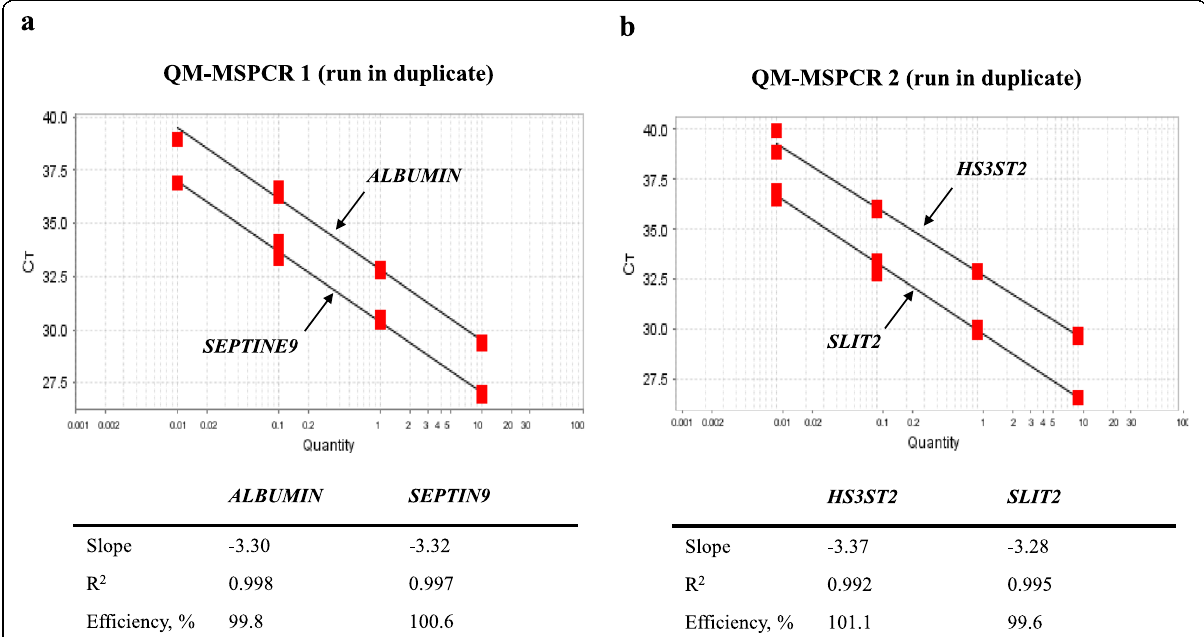
Fig. 4 LoQ for the Methylation assay. The limit of quantification (LoQ) for the QM-MSPCR1 ( a ) and QM-MSPCR2 ( b ) was determined by carrying out a series of dilutions with bisulfite converted DNA quantities of 10, 1, 0.1 and 0.01